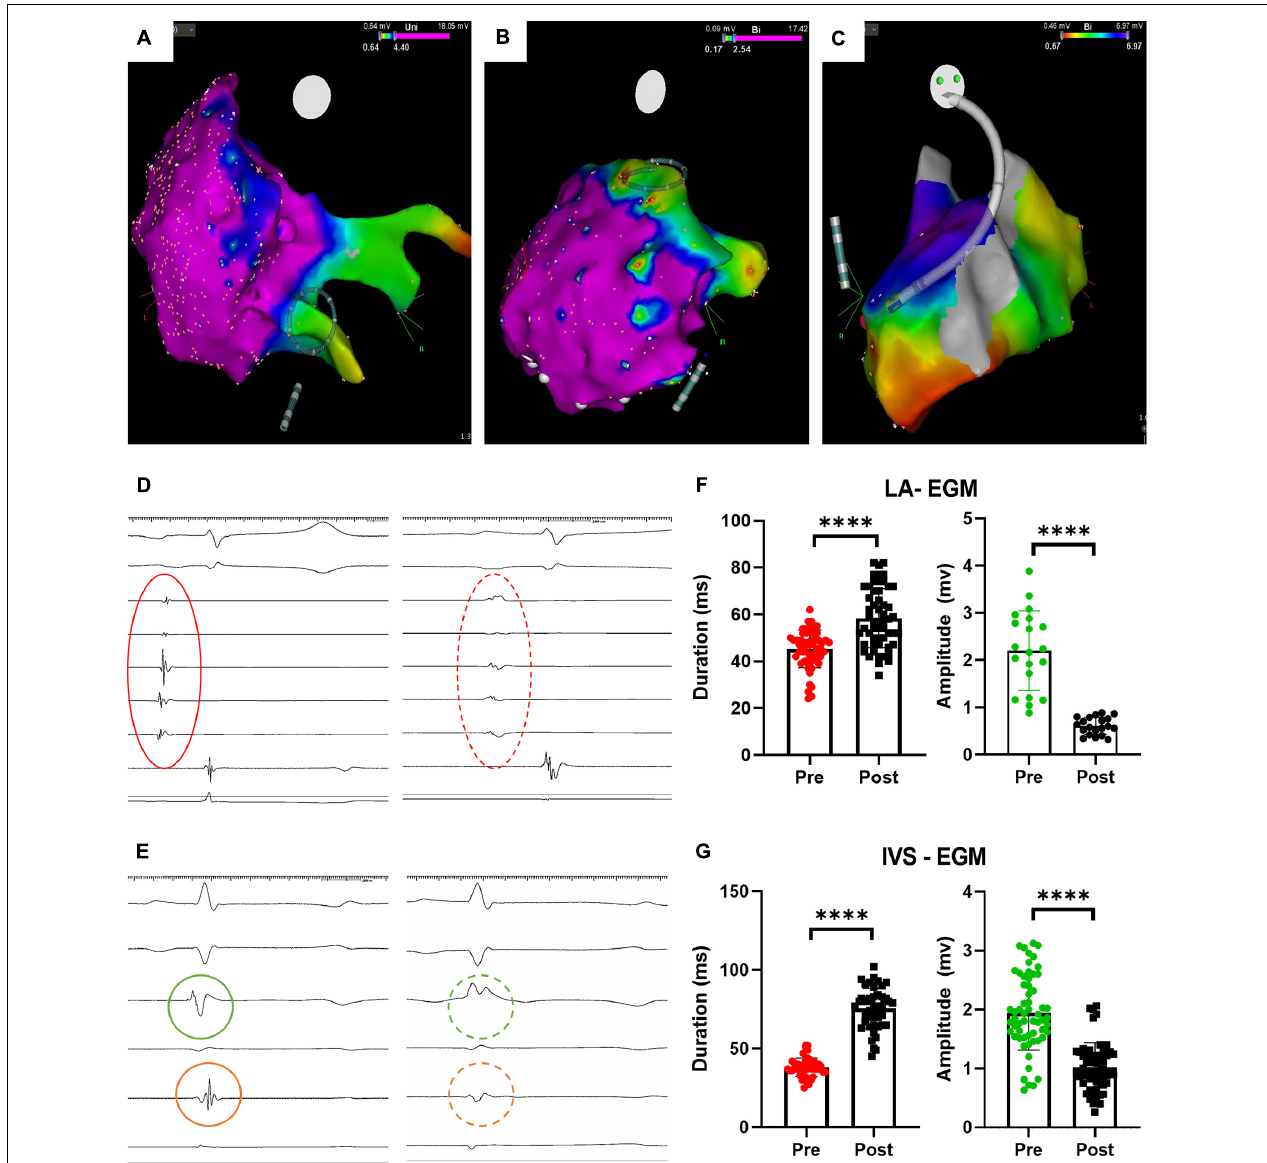
FIGURE 2 | Procedural imaging and electrophysiological results. (A) Circular catheter positioning before pulmonary vein ostium ablation; (B) Circular catheter positioning before atrial wall ablation; (C) catheter positioning across the interventricular septum before ablation; (D) atrial electrograms before (red continuous circle) and after (red dashed circle) ablation; (E) ventricular electrograms before (green, on left ventricle, and orange, on right ventricle, continuous circle) and after (dashed circles) ablation; (F) atrial electrograms changes upon ablation (**** p < 0.0001); (G) ventricular electrograms changes upon ablation (**** p < 0.0001). LA = left atrium; IVS = interventricular septum, EGM = electrogram.